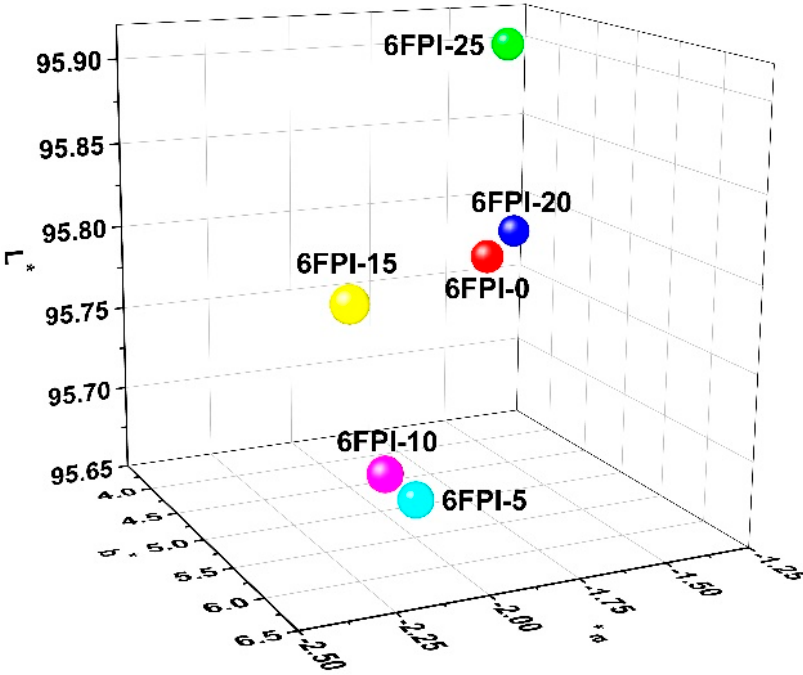
Figure 9. CIE Lab parameters of 6FPI-POSS composite films. Although the incorporation of TSP-POSS showed some positive and negative effects on the optical properties of the PI composite films, the optical properties of the polymers were not the main concerns in the current research. Figure 10 shows the curve of the dielectric constants of the PI films as a function of frequency. All the PI films showed stable D k values in the frequency range from 10 3 to 10 6 Hz. The 6FPI-0 film, an intrinsically low- D k PI [28], showed the D k value of 2.84 at 1 MHz and the D f value of 0.009. The addition of TSP-POSS additives apparently reduced the D k values of PI composite films, while the D f values maintained the same level. With the increase of the TSP-POSS contents, the D k values of the PI films decreased from 2.84 (1 MHz) of 6FPI-0 to 2.52 (1 MHz) of 6FPI-25, while the D f values correspondingly changed from 0.009 (1 MHz) to 0.011 (1 MHz). According to the Clausius–Mossotti equation, the increase of the internal space of materials can reduce the dielectric constant [31]. Herein, the introduction of TSP-POSS additives with a large bulky structure can break the tight packing of PI molecular chains, thus reducing the dielectric constant of PI composite films. The low- D k feature of the current PI composite films is mainly attributed to the synergistic effects of the bulky hexafluoroisopropylene groups in PI matrix and the bulky silsesquioxane groups in TSP-POSS additives. The low D k value of 2.52 at 1 MHz makes the 6FPI-25 a good candidate as high-performance substrates for spacecraft